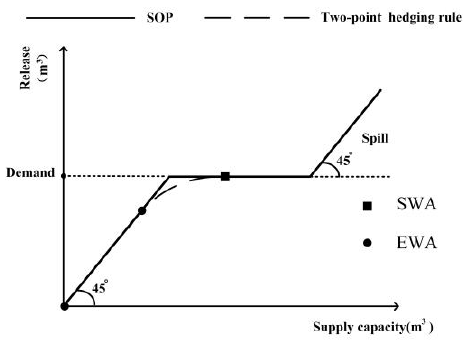
Figure 3. Scheme of two-point hedging rule.